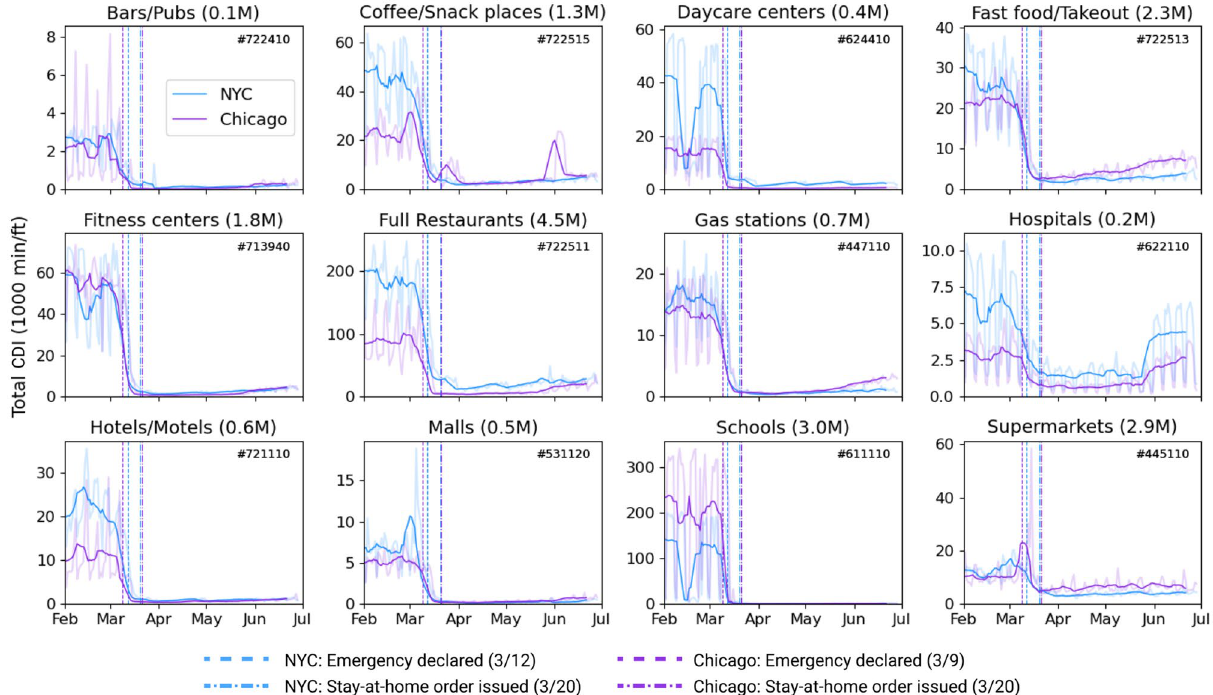
Figure 5. Trends of CDI by industry. Daily trends of CDI to POIs of 12 popular industries in NYC and Chicago, shown as 7-day moving averages. The lighter shaded curves are the daily trends. For reference, the 6-digit NAICS code and the total number of multi-person visits to POIs between February 1 and June 28. The dates of two main mobility restrictive policies in these cities are also